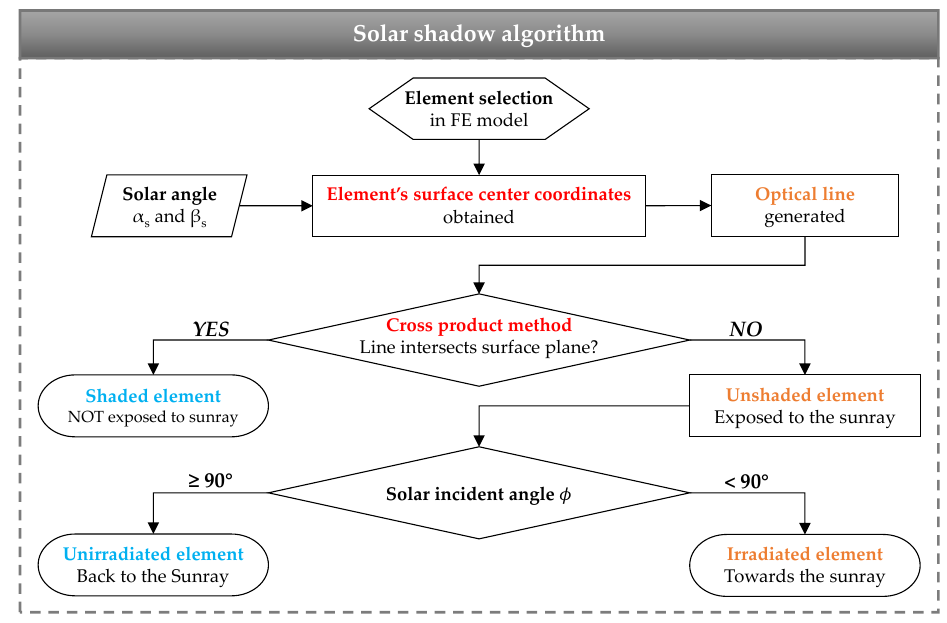
Figure 5. Flowchart of solar shadow simulation algorithm in FE model.